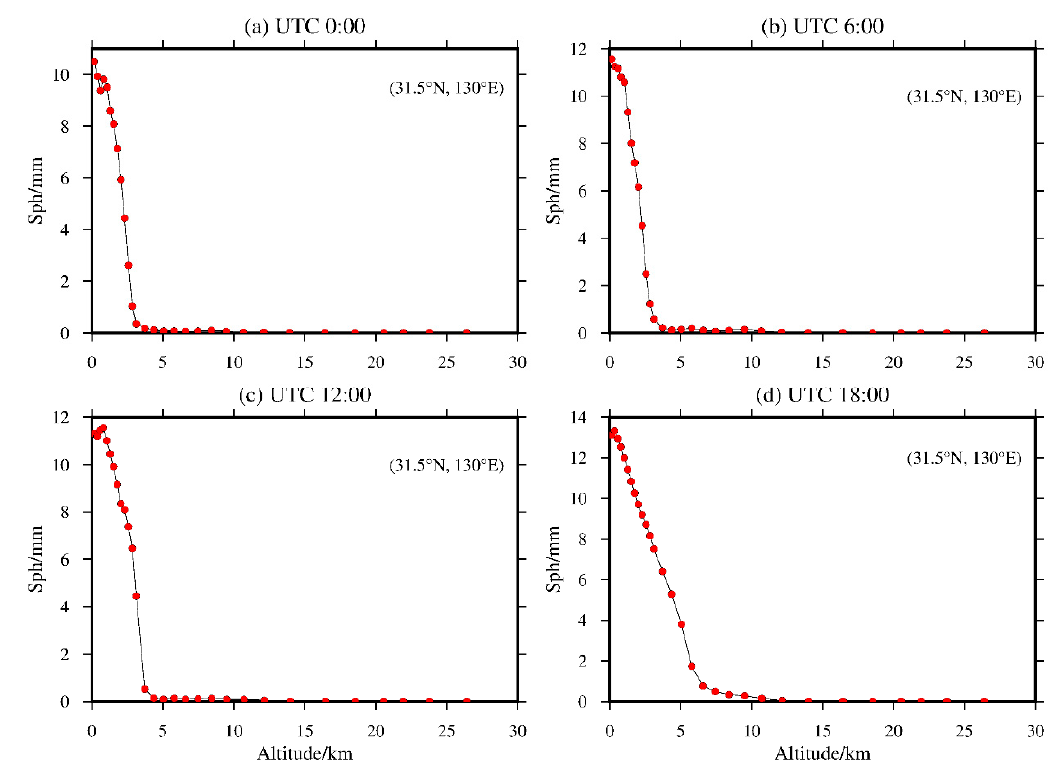
Figure 2. Variation in the specific humidity of the grid point (31.5° N, 130.0° E) at UTC ( a ) 0:00, ( b ) 6:00, ( c ) 12:00 and ( d ) 18:00 in the elevation direction.